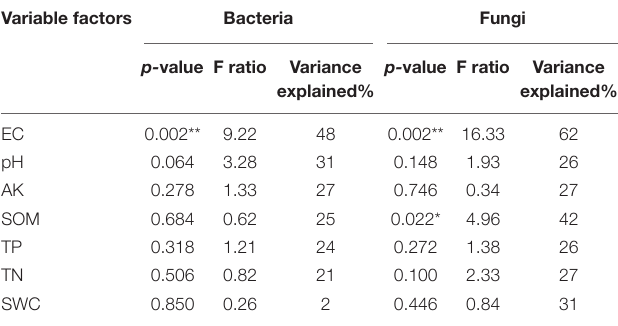
TABLE 4 | Correlation analysis of soil physicochemical properties and microorganisms of fair ring by Monte Carlo permutation test. Variable factors Bacteria